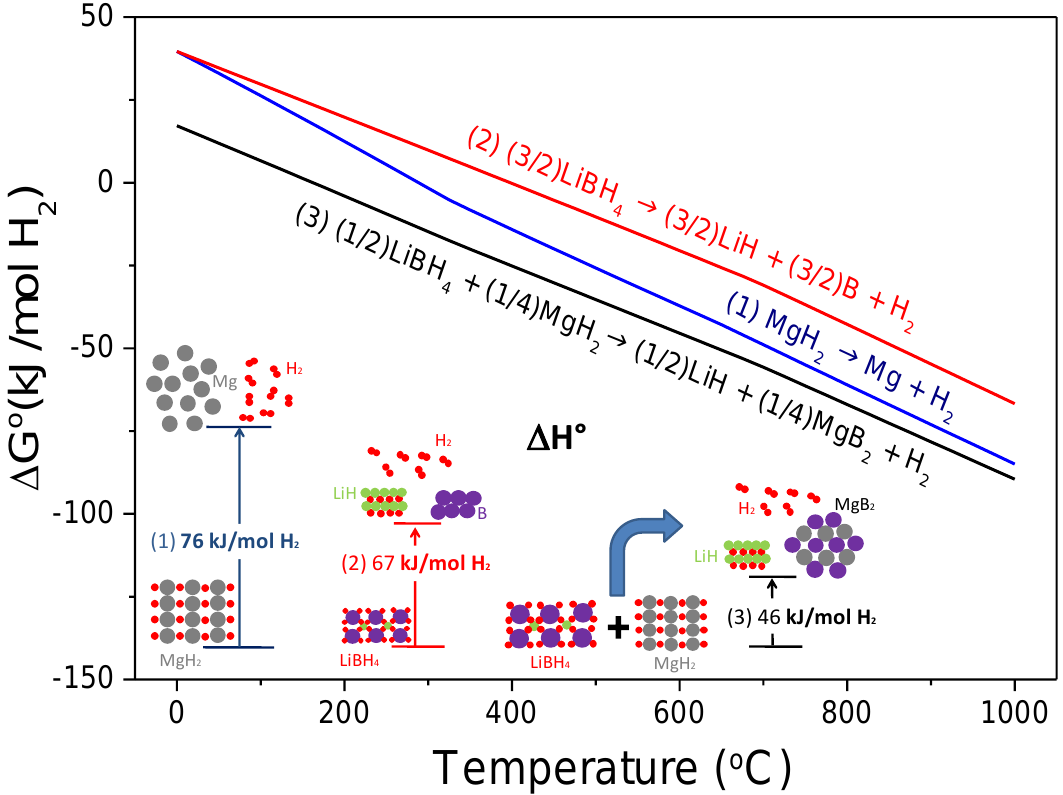
Figure 2. Free energy per mol of H 2 as a function of temperature and the standard enthalpy of a reaction of the hydride system 2LiBH 4 + MgH 2 .